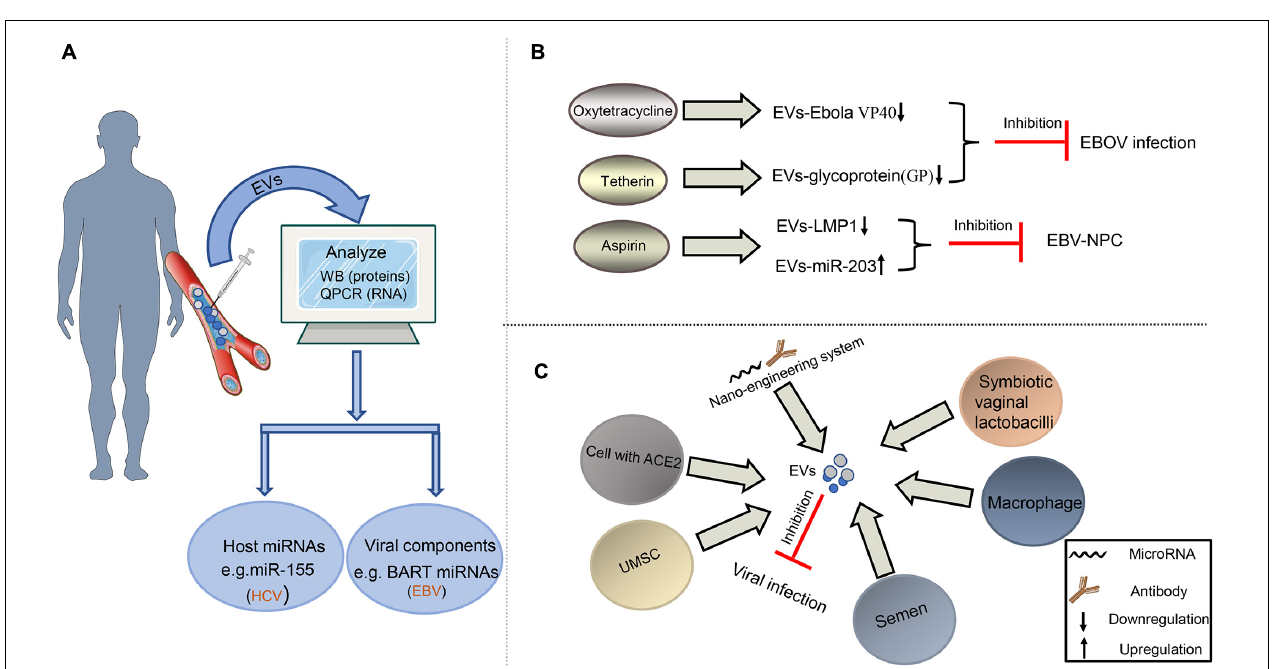
FIGURE 4 | Diagnosis and treatment of virus-related diseases based on EVs. (A) EVs as potential biomarkers in the diagnosis of viral infection. EVs from plasma or serum can be extracted and analyzed for the expression level of some special molecules by Western blot or qPCR assays to help the diagnosis of some viral infection. (B) EVs as drug target to fight against viruses. Some drugs, such as oxytetracycline, tetherin, and aspirin, may regulate the composition of EVs to inhibit EBOV infection or the development of EBV-NPC. (C) EVs as tool to restrict viral infection. The EVs derived from some cells or bacteria carry antiviral factors or viral receptors to limit viral infection. In addition, the artificial EVs produced by the nano-engineering system contain viral antibodies or microRNAs, which can disturb viral replication, survival, and proliferation.